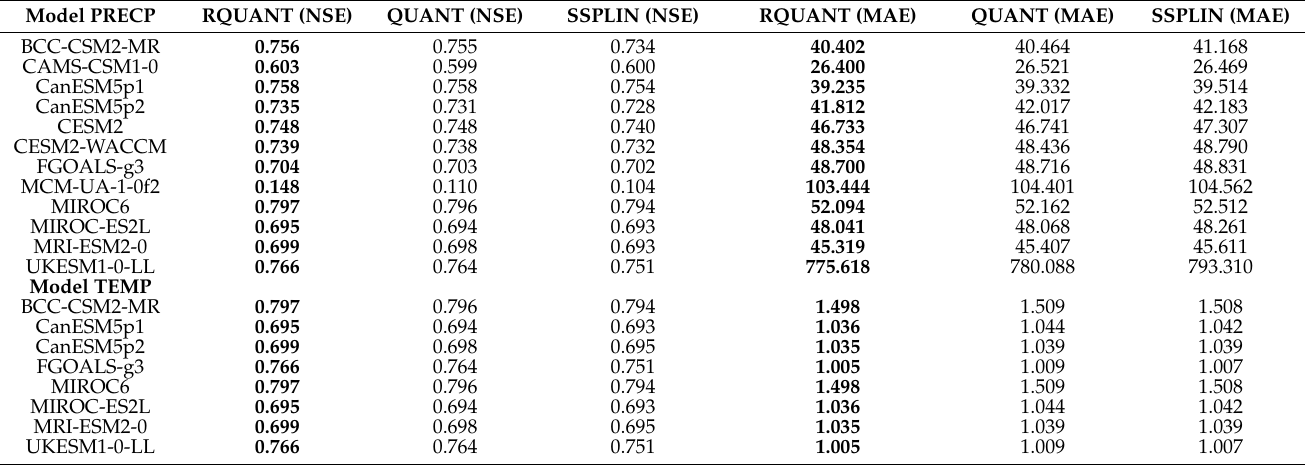
Figure A6. Spatial distribution of CMIP6-BCC-CSM2-MR model daily mean precipitation (mm/day) for ( a ) SSP126 (1.2–8.2), ( b ) SSP245 (1.1–7.8), ( c ) SSP370 (1.2–8.1), and ( d ) SSP585 (0.9–7.6) scenarios over the UBNB for the long-term projections (2071–2100).The spatial distributions of mean precipitation for four SSP scenarios looks identical but the range of the value are different. Table A1. Non parametric quantile mapping methods performance evaluation using Nash – Sutcliff efficiency (NSE) and mean absolute error (MAE) values for bias correction.